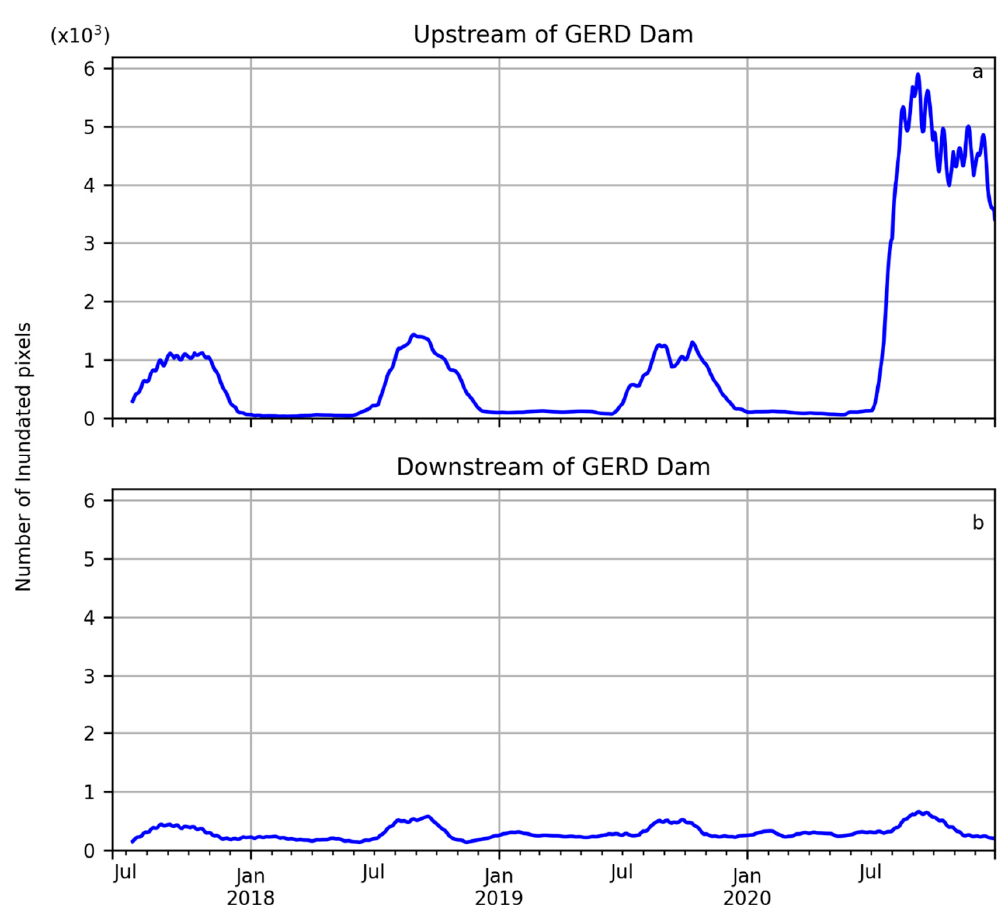
Figure 4. ( a , b ) Number of inundated pixels underwater for selected upstream and downstream locations near GERD as observed from the Sentinel-1 images. The threshold for identifying water/non-water pixels is − 18 dB. The upstream region corresponds to a polygon with boundaries at (35.064 ◦ E, 11.165 ◦ N), (35.087 ◦ E, 11.154 ◦ N), (35.101 ◦ E, 11.220 ◦ N), and (35.093 ◦ E, 11.221 ◦ N) whereas the downstream region corresponds to a rectangular boundary with latitudinal extent of (11.210 ◦ N, 11.226 ◦ N) and longitudinal extent of (35.054 ◦ E, 35.087 ◦